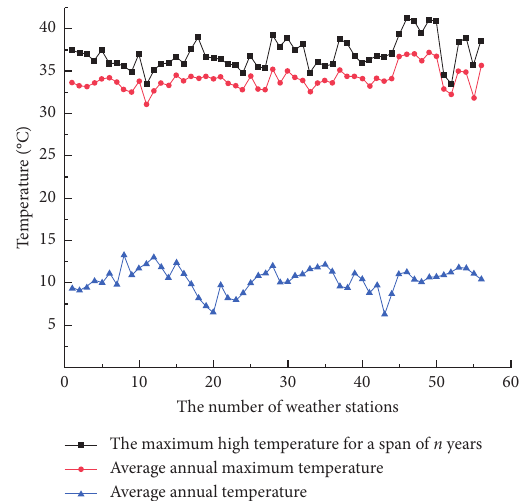
Figure 4: Main climate variables of high